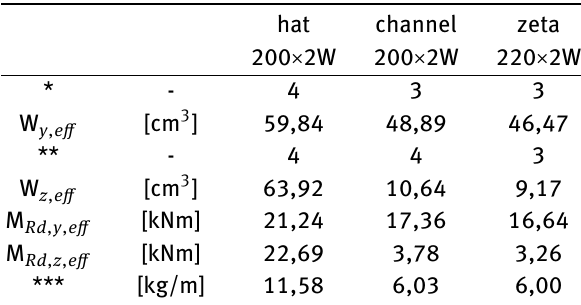
Figure 11: View of effective cross-section area of analysed profiles with stiffener on the web: a) channel profile, bending by the main axis y-y, b) channel profile, bending by the main axis z-z, c) zeta profile, bending by the main axis y-y, d) zeta profile, bending by the